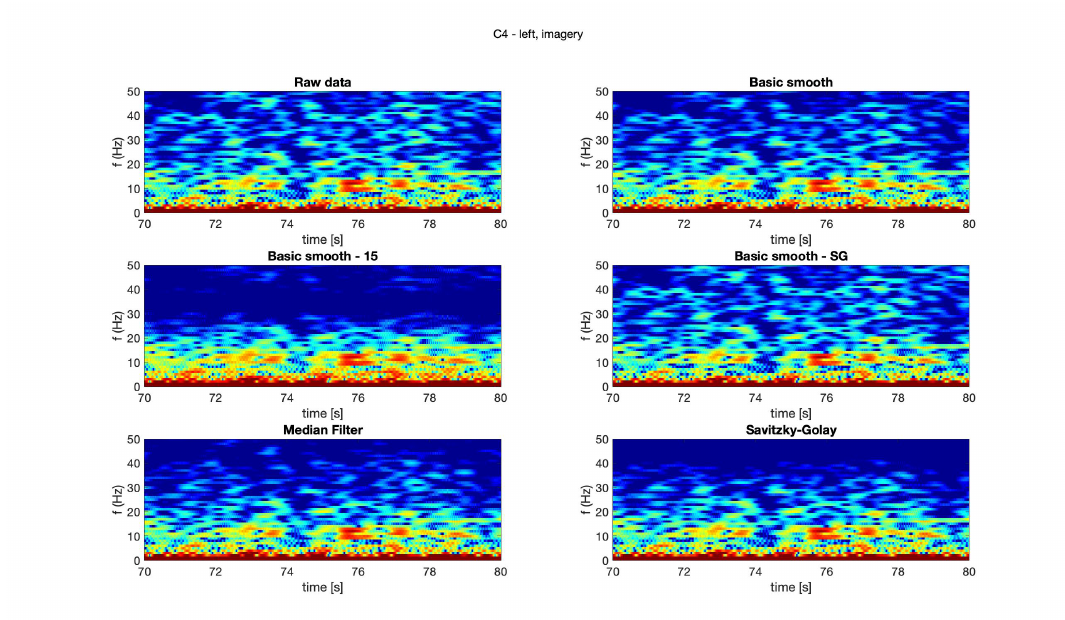
Figure 13. Spectrogram—C4, left hand, imagery movement.